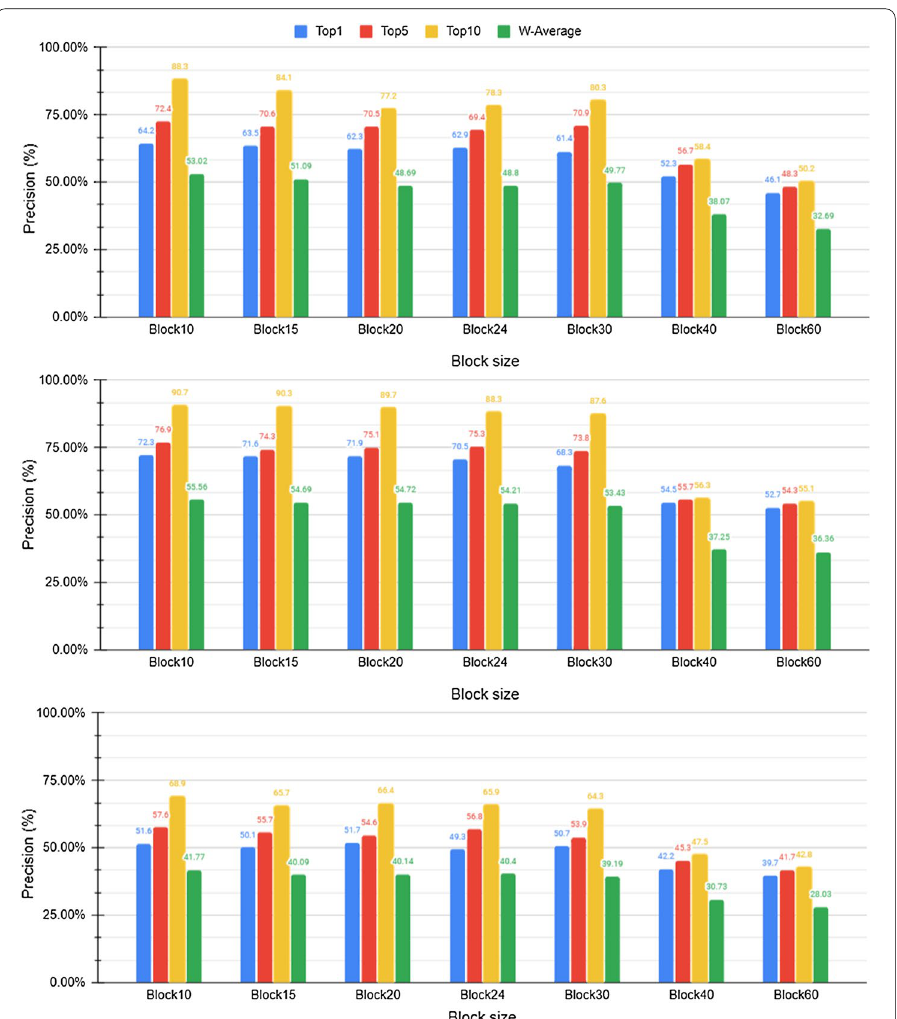
Fig. 9 Matching precision based on different block sizes (%), Up: UCF11, Middle : UCF50, Down: